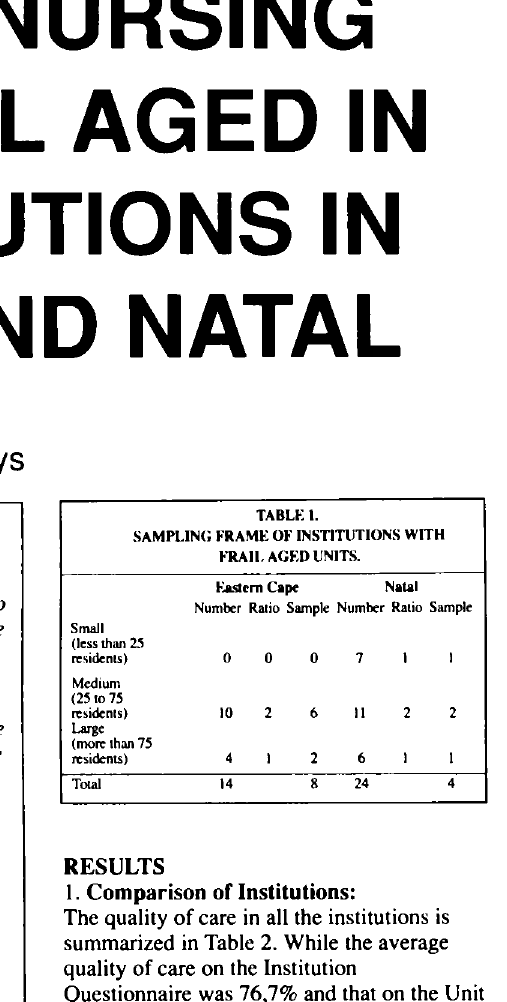
TABLE 1. SAMPLING FRAME OF INSTITUTIONS WITH FRAll- AGED